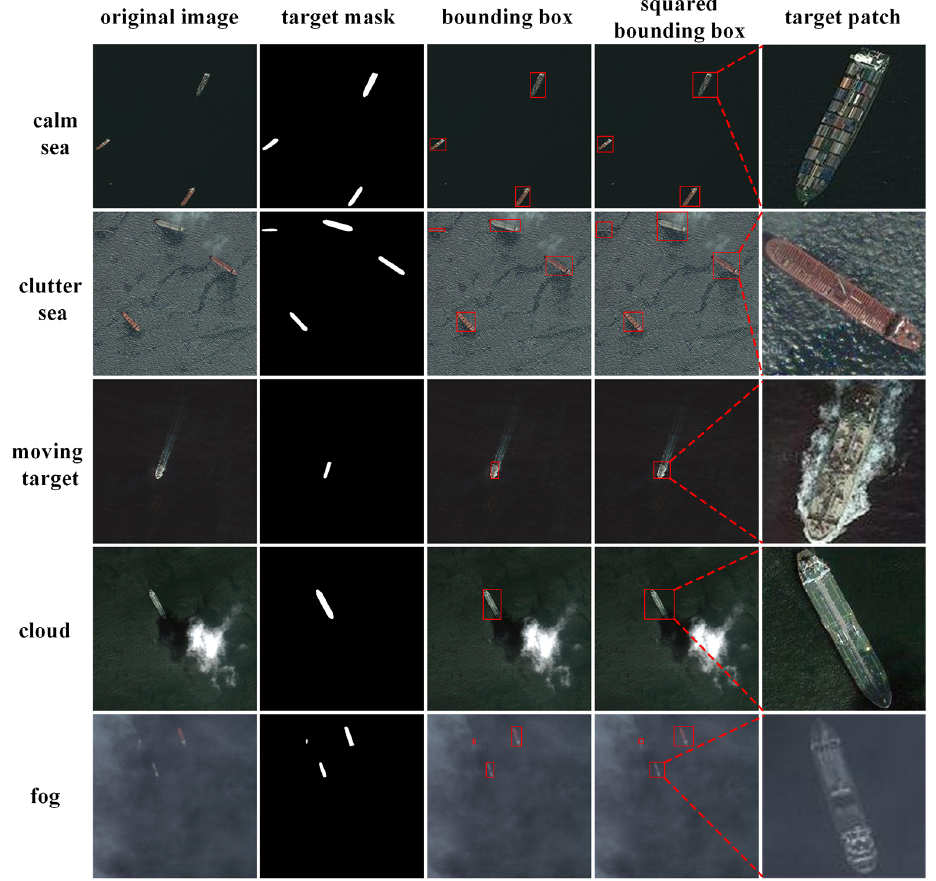
Figure 7. Some image patches under different conditions in our